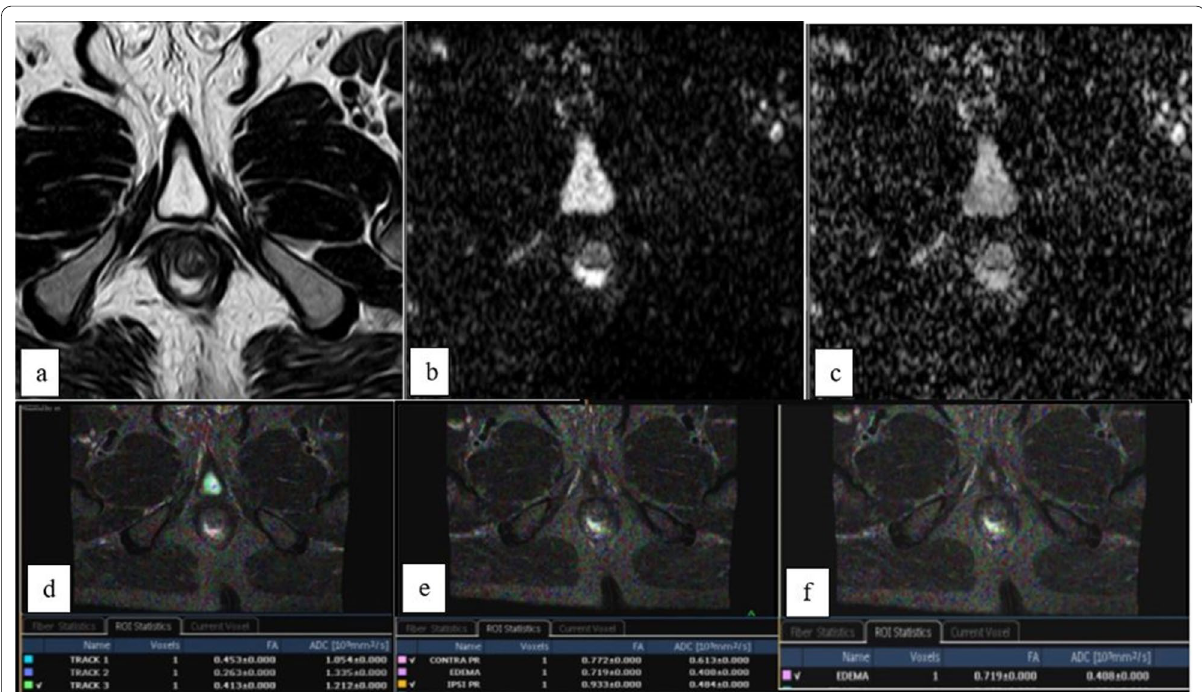
Fig. 7 a axial T2WI, b DWI and c ADC maps for an inter-sphincteric track surrounding the sphincter from 6 to 9 O’ clock with internal opening breaching the internal sphincter at 7–8 O’ clock and showing high T2WI SI bright DWI signal with still high ADC signal (not true restriction) in spite of being clinically and DTI active with low FA and ADC values as shown in axial DTI/T2 fused images with ROI (FA and ADC) values placed in d the inter-sphincteric track, e ipsilateral and contralateral sphincters and f surrounding edema area with FA values 0.413, 0.933, and 0.772 and 0.719 with ADC values 1.212, 0.484, 0.613 and 0.408 10 3 mm 2 /s, ×